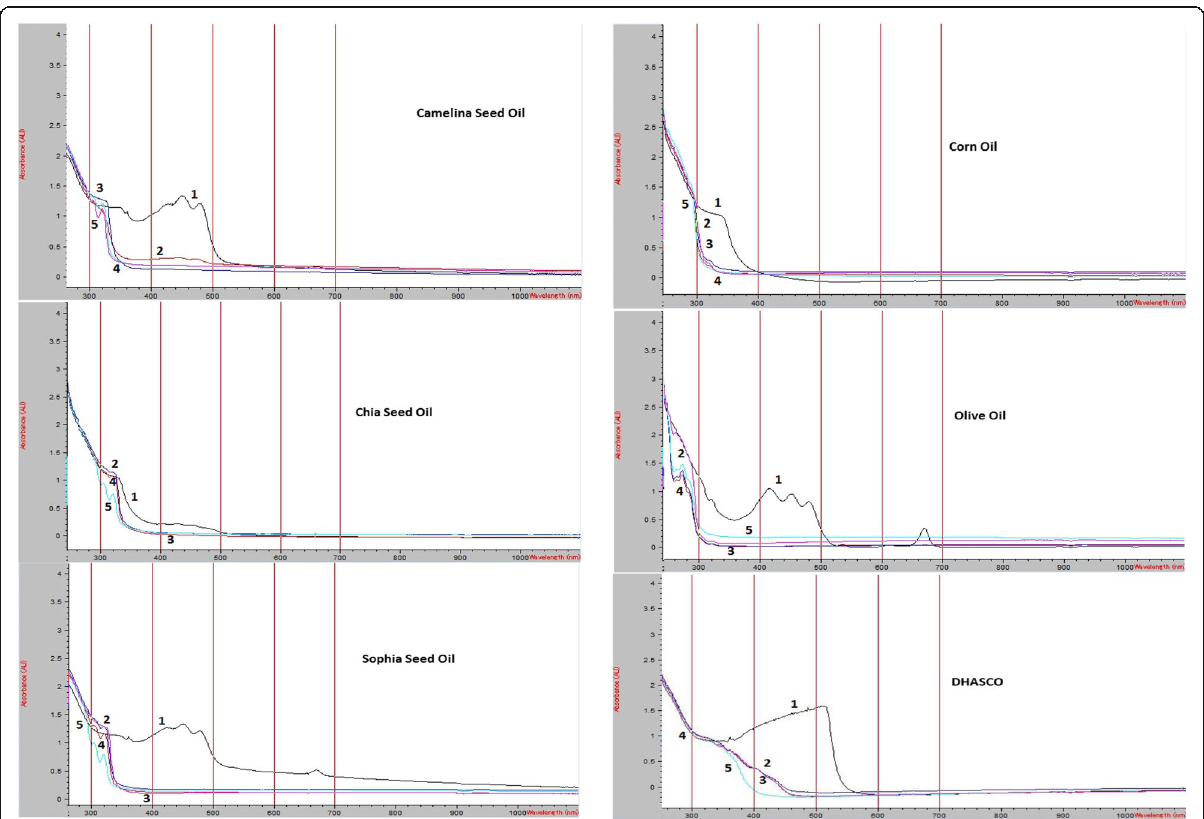
Fig. 1 Visible spectra of pigments in seed oils (1) original oil, (2) simplyfied stripped oil 1 h, (3) simplyfied stripped oil 2 h, (4) simplyfied stripped oil (twice, 1 h), and (5) column stripped